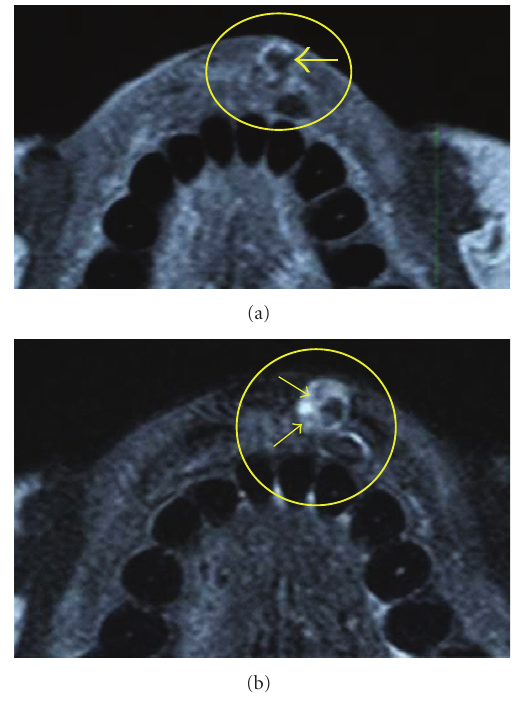
Figure 2: (a) Axial T1-weighed MR image of the lesion (inside yellow circle). This image shows that the margin of the lesion showed an enhanced line with no signal area in the center of the lesion (arrow). TR was 542 (milliseconds) and TE was 9 (milliseconds). The sequence of MR image was FSE, and NEX was 512 × 512. (b) Axial T2-weighed MR image of the lesion (inside yellow circle). This image shows a no signal intensity area in the center of the lesion and also a no signal intensity area beside two low-signal intensity dots (arrows). TR and TE parameters of T2 weighed MR image were 3000 (m sec) and 80 (m sec). The sequence of MR image was FSE, and NEX was 512 ×